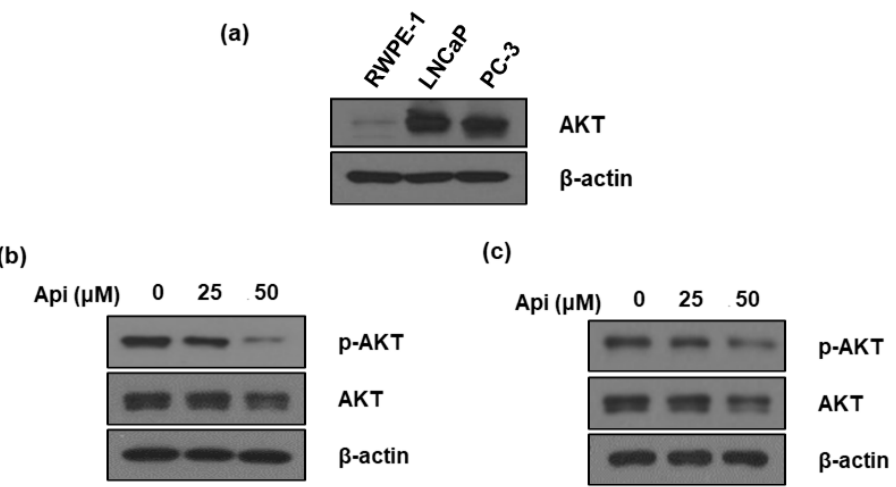
Figure 5. Effect of apigetrin on AKT and p ‐ AKT in LNCaP and PC ‐ 3 cells. ( a ) Basal AKT expression in prostate cell lines (human normal and cancer cells). LNCaP cells ( b ) or PC ‐ 3 cells ( c ) were